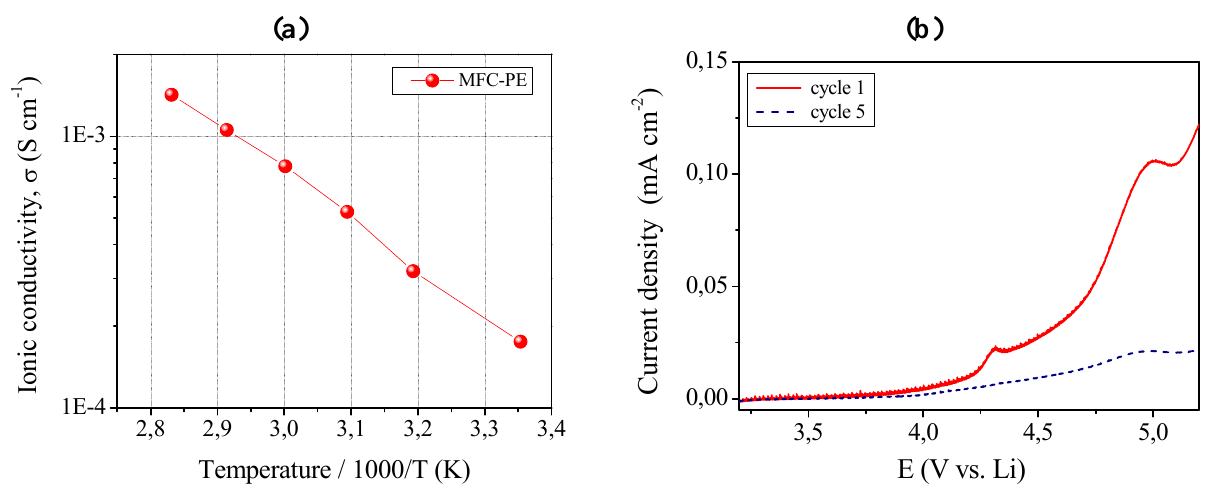
Figure 10. ( a ) Conductivity versus temperature plot of the MFC-PE reinforced quasi-solid polymer electrolyte. Data obtained by impedance spectroscopy; ( b ) Current vs . voltage curves at ambient temperature for